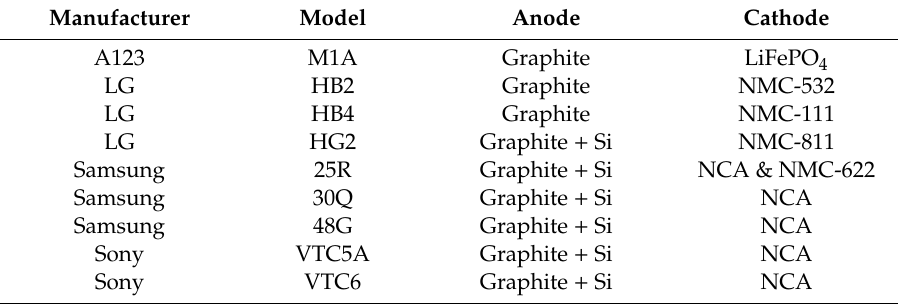
Table 5. Active materials identified by energy dispersive x-ray spectroscopy